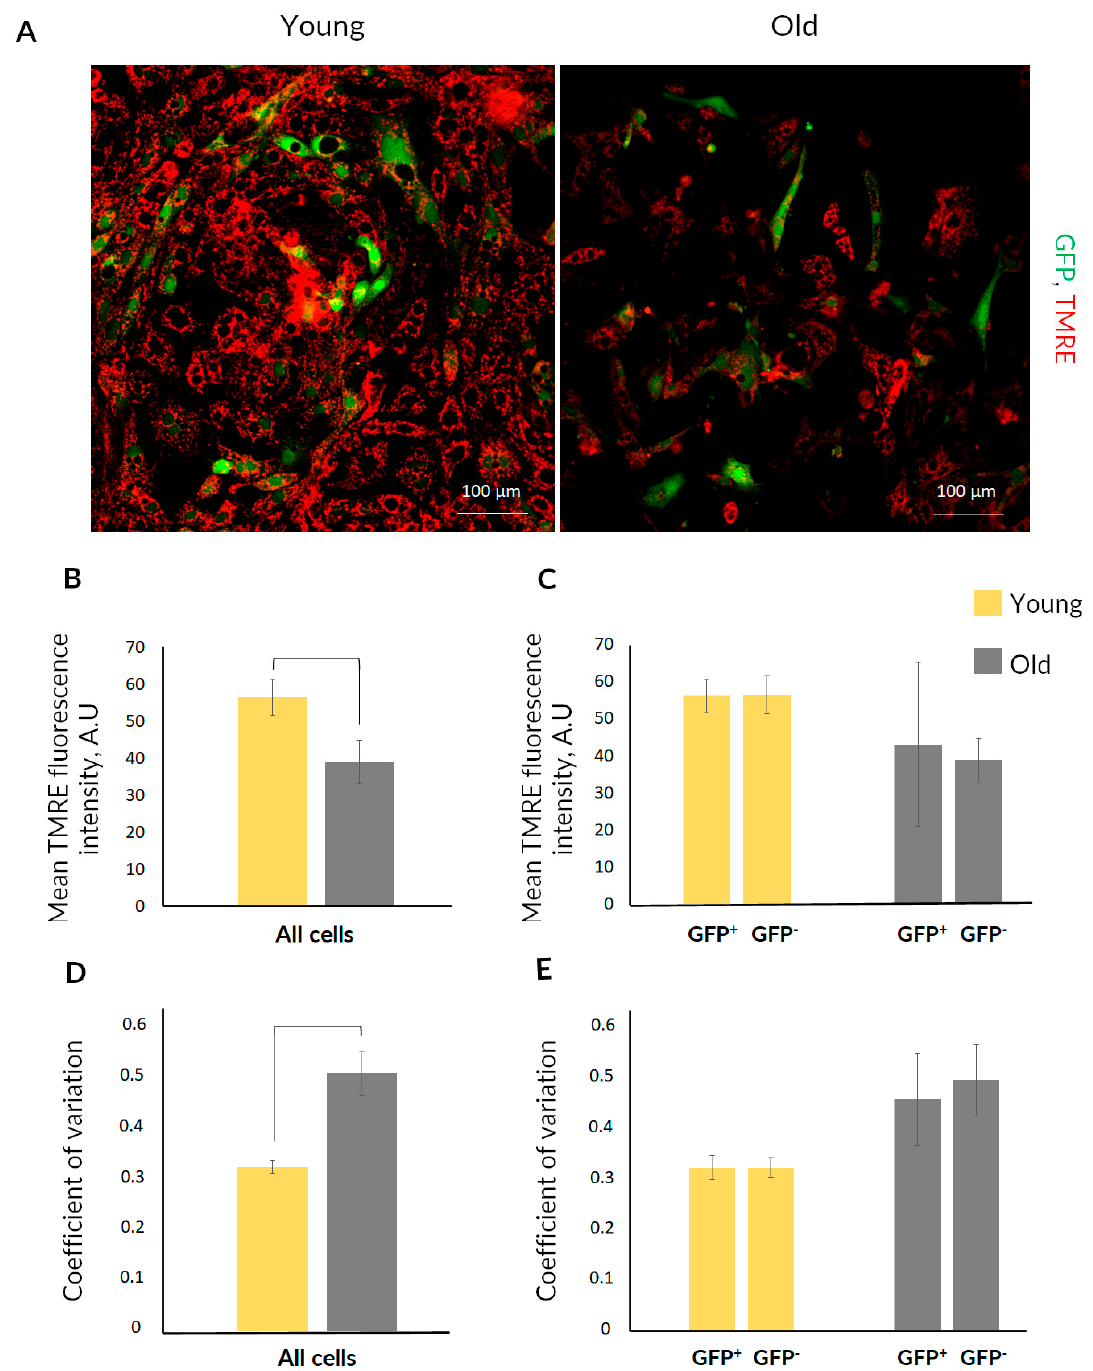
Figure 5. Mitochondrial membrane potential in RTC cultures from young and old nestin-GFP mice.